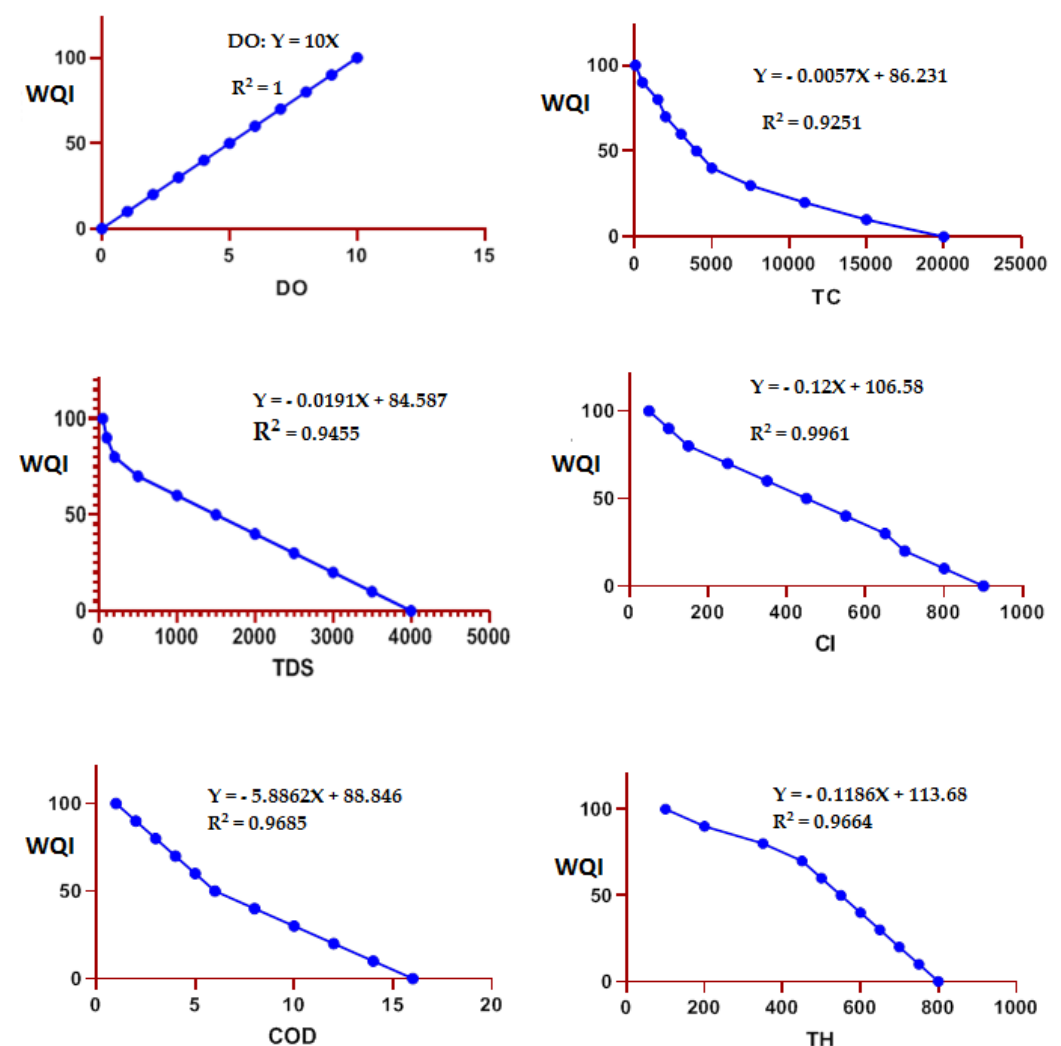
Figure 2. The water quality curves of the sub-indices of the six parameters.